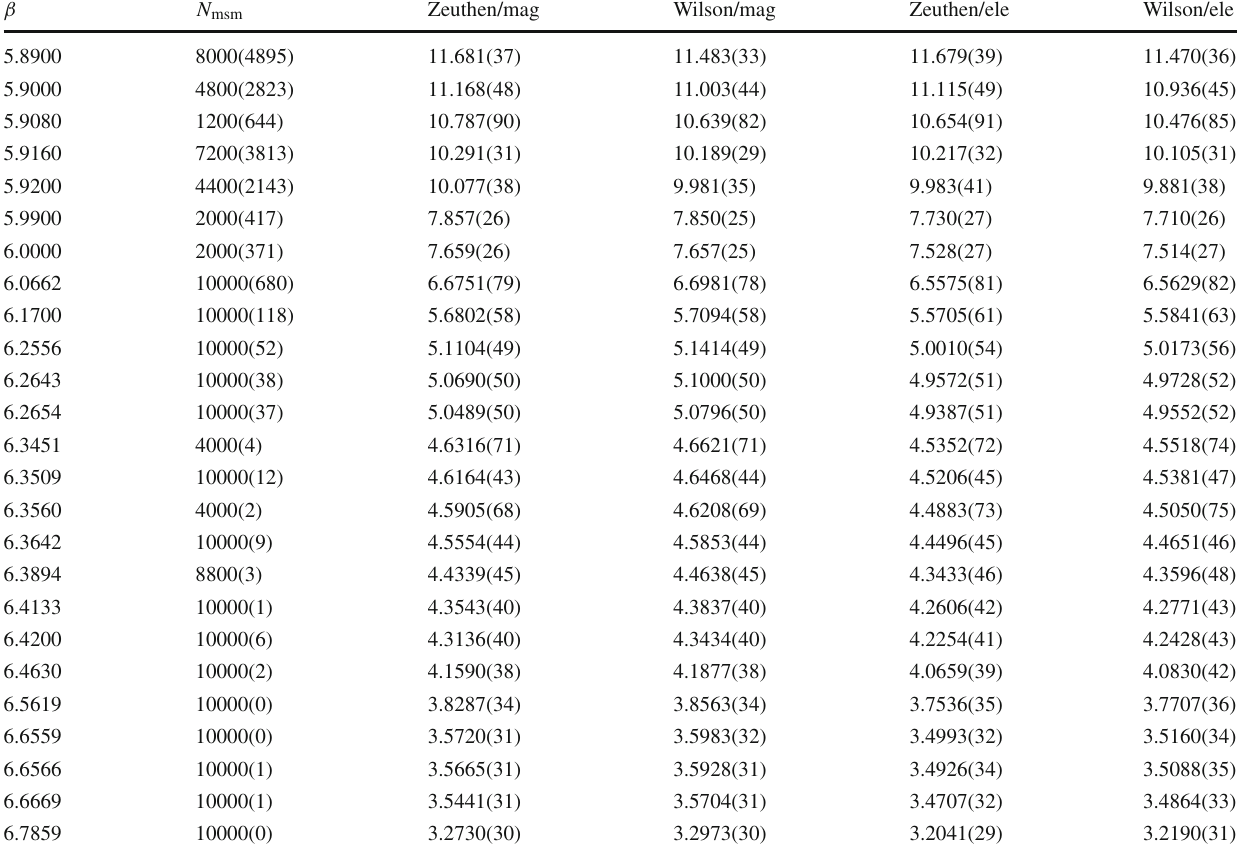
Table 14 GF coupling data for L / a =